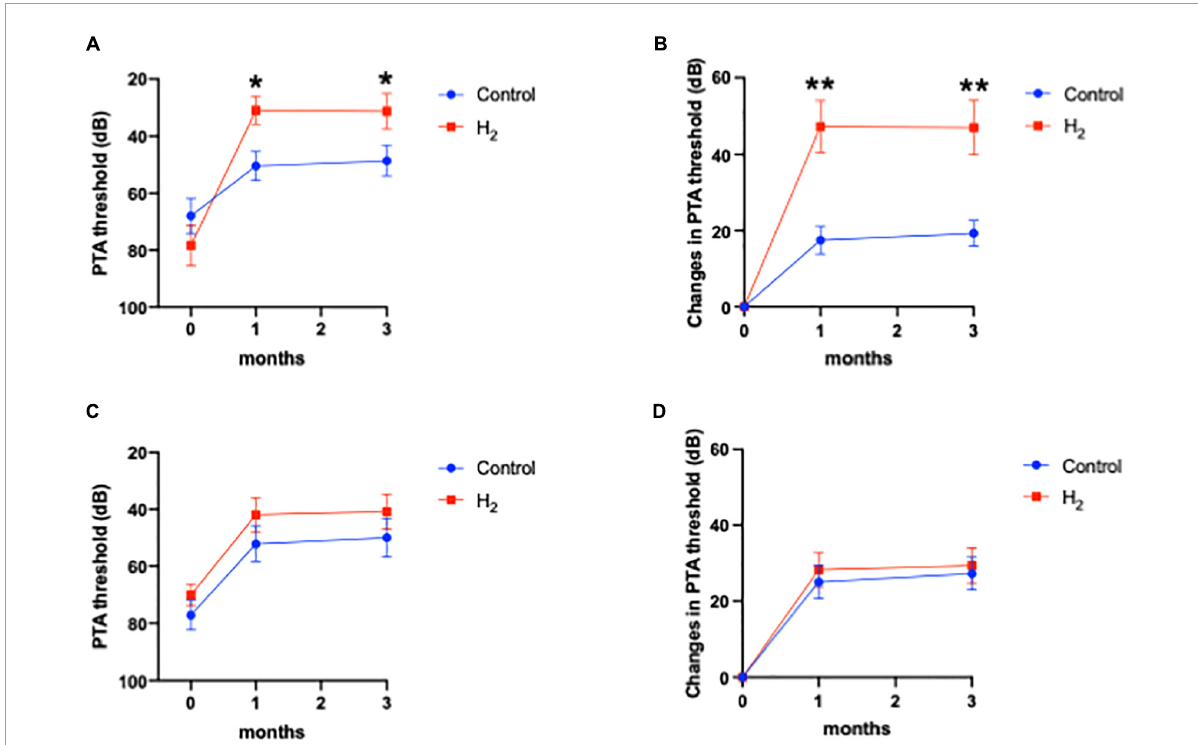
FIGURE6 Hearing outcomes depending on diabetes. (A) PTA threshold among patients with diabetes. (B) Changes in the PTA threshold among patients with diabetes. (C) PTA threshold among patients without diabetes. (D) Changes in the PTA threshold among patients without diabetes. Among patients with diabetes, both the PTA threshold and changes in PTA threshold were significantly better in the H 2 group 1 and 3 months after treatment than in the control group. However, these significant differences were not observed among patients without diabetes. * P < 0.05, ** P <